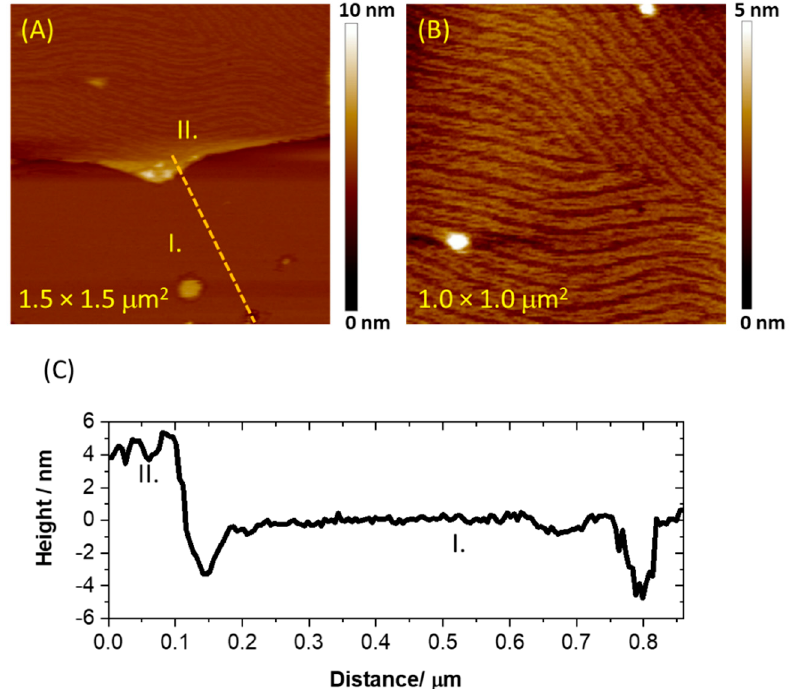
Figure 3. ( A ) An AFM image collected for lipid assembly deposited on thioglucose-modified Au(111) after one cycle of freeze–thaw treatment. ( B ) An AFM image of the double bilayer region with ripple phase structure. ( C ) The cross-sectional profile for lipid assembly after one freeze–thaw cycle. The profile was taken along the orange dotted line displayed in panel ( A ). The images were collected in Peak Force Tapping mode.